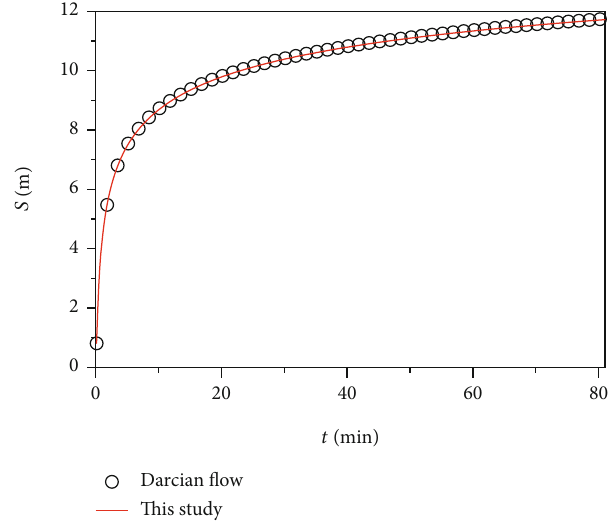
Figure 10: Comparison of the curve for the non-Darcian fl ow model and constant head test model.